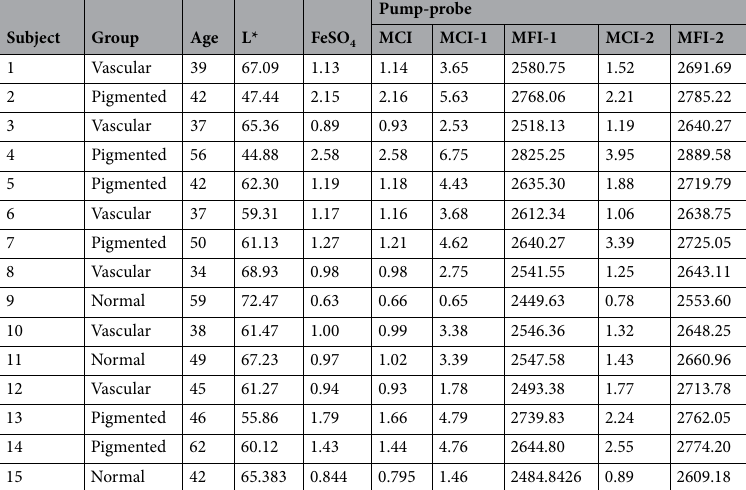
(Fig. 6A). The same results were observed in MFIs, which contained MFI-1 in the epidermal basal layer and MFI-2 in the dermal region as well, with significantly higher values in the pigmented group than in the vascular group and normal group, but no significant difference was found between the latter two groups (Fig. 6B). All the data and details of patients were shown in Table 1.